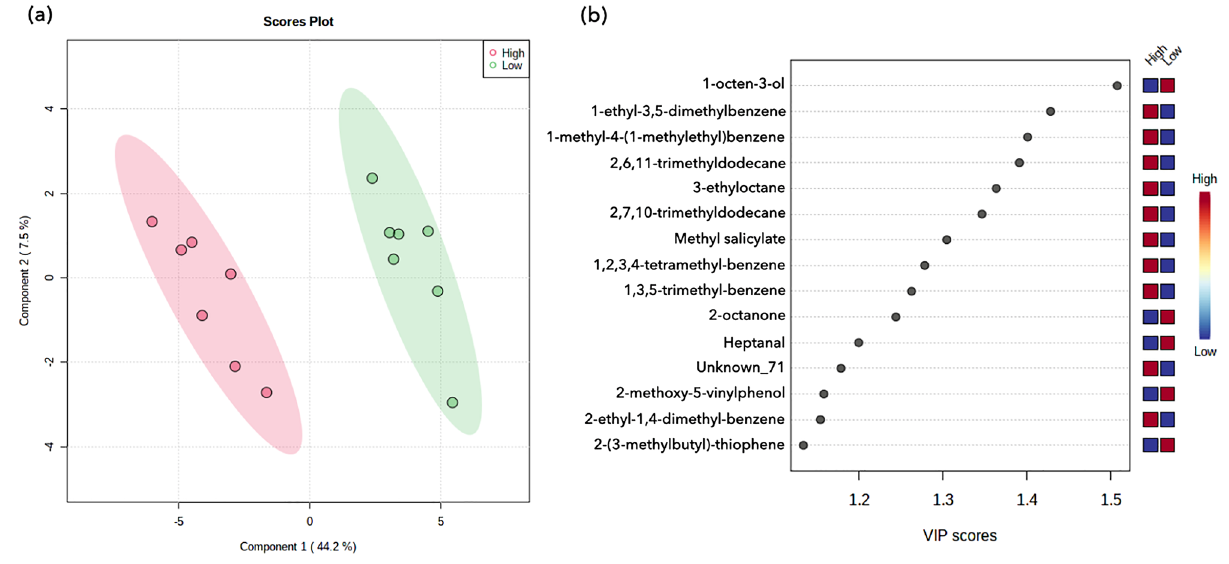
Figure 3. PLS-DA of the HS-SPME GC/MS data of non-aromatic rice cultivars. ( a ) PLS-DA score plot. ( b ) VIP scores of compounds. The color-coded boxes indicate peak area ratio as high (red) and low (blue), first column is high eating-quality cultivars, and second column is low eating-quality